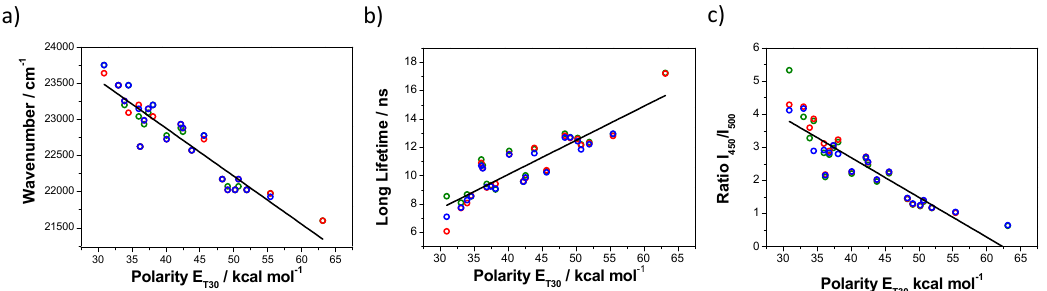
Figure 2. Dependence with the E T 30 (kcal mol –1 ) value of ( a ) wavenumber of emission maximum peak, ( b ) long lifetime and ( c ) intensity ratio between emission at 450 nm and emission at 500 nm ( I 450 / I 500 ) of acridones 1 (green), 2 (red) and 3 (blue).